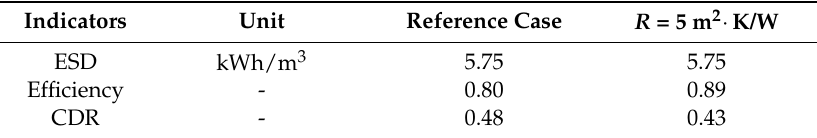
Table 9. Indicators for the EHF system for two different insulation